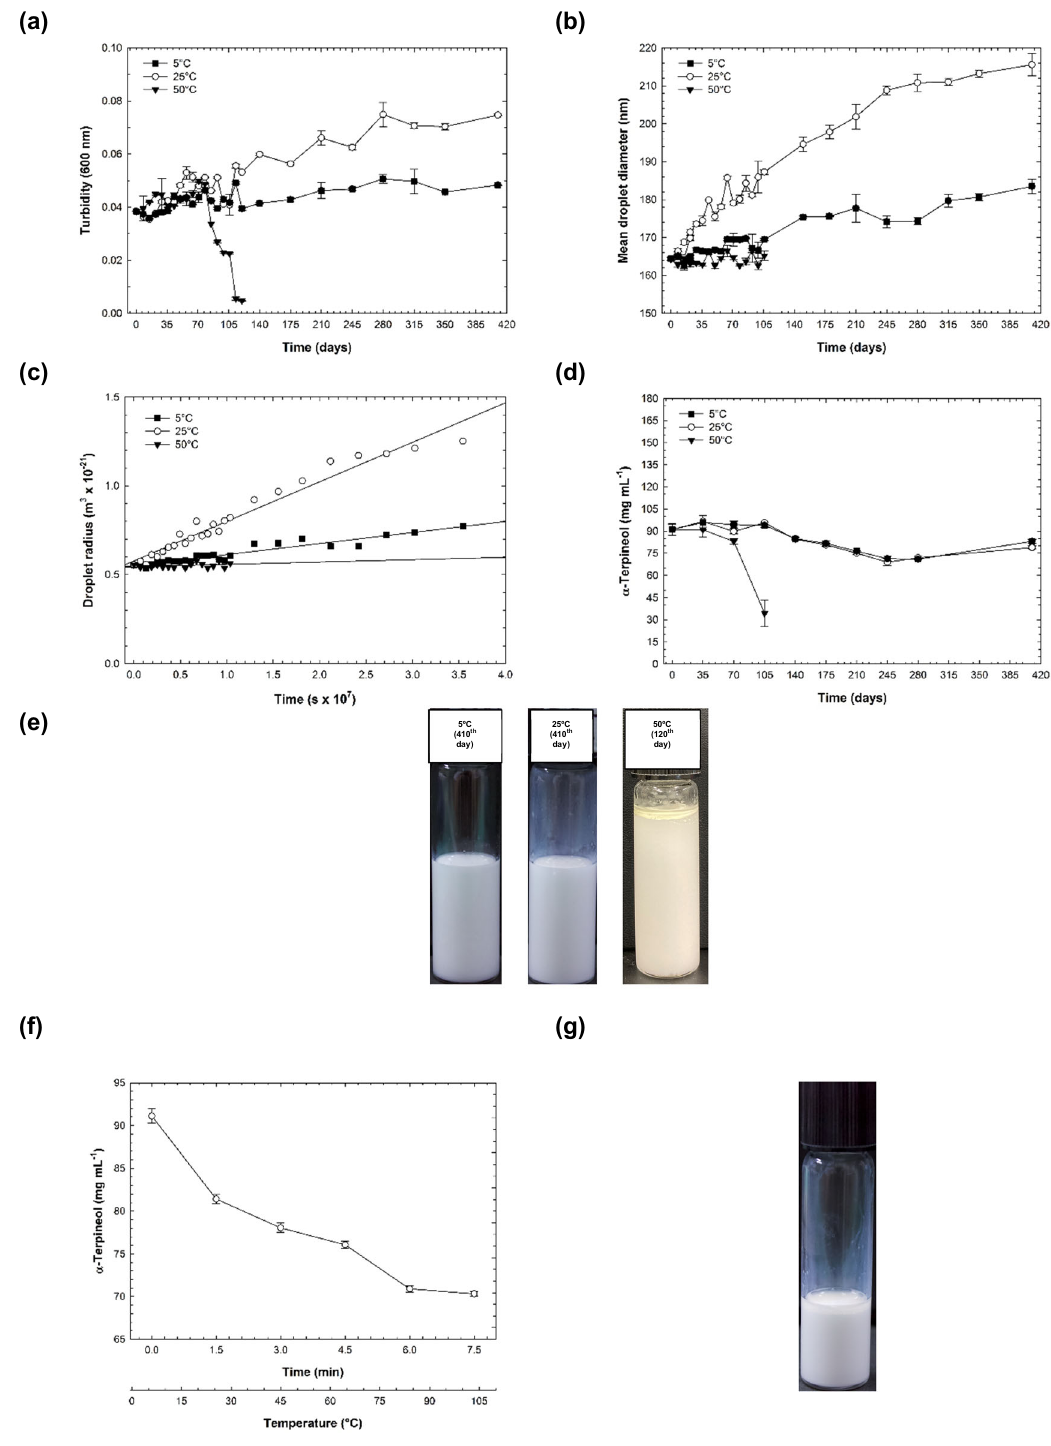
With the exemption of graph (c); all values (n = 3) are expressed as mean ± s.d. Fig. 2 Plots for stability studies of 9 α TOH-NE stored at 5, 25, and 50 °C. ( a ) Turbidity at 600 nm for 9 α TOH-NE watery 200-fold; ( b ) Mean droplet diameter (nm) versus time (410-days); ( c ) The cube of the droplet radius (r 3 ) against time (s); ( d ) Retention of nanoemulsi fi ed α -TOH (mg mL − 1 ) into 9 α TOH-NE as time passed. Values accompanied by different lowercase letters (a-j) indicate signi fi cant differences (Duncan Multiple Range Test; p < 0.05). ( e ) Photographs of the 9 α TOH-NEs. Not noticed by the picture, but for 9 α TOH-NE at 50 °C a phase separation was also observed in the middle of the glass vial additionally to the oil accumulation on the top. ( f ) Simulation of cooking process and their impact on the retention of nanoemulsi fi ed α -TOH (mg mL − 1 ) as a function of time (min) and temperature (°C); ( g ) Photograph of the 9 α TOH-NE submitted to the cook process simulation (after 5 min at 105 °C) where an oiling off can be observed. Considering the high content of water into the 9 α TOH-NE, the fi nal volume was reduced c.a . 5-fold compared to the initial